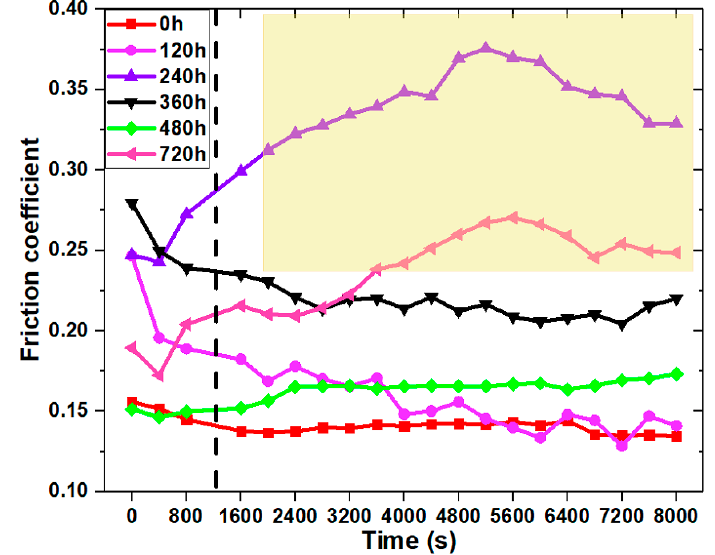
Figure 4. The coefficient of friction (COF) of UHMWPE for different aging times. Reprinted with Figure 4. The coe ffi cient of friction (COF) of UHMWPE for di ff erent aging times. Reprinted with permission from [88]. permission from